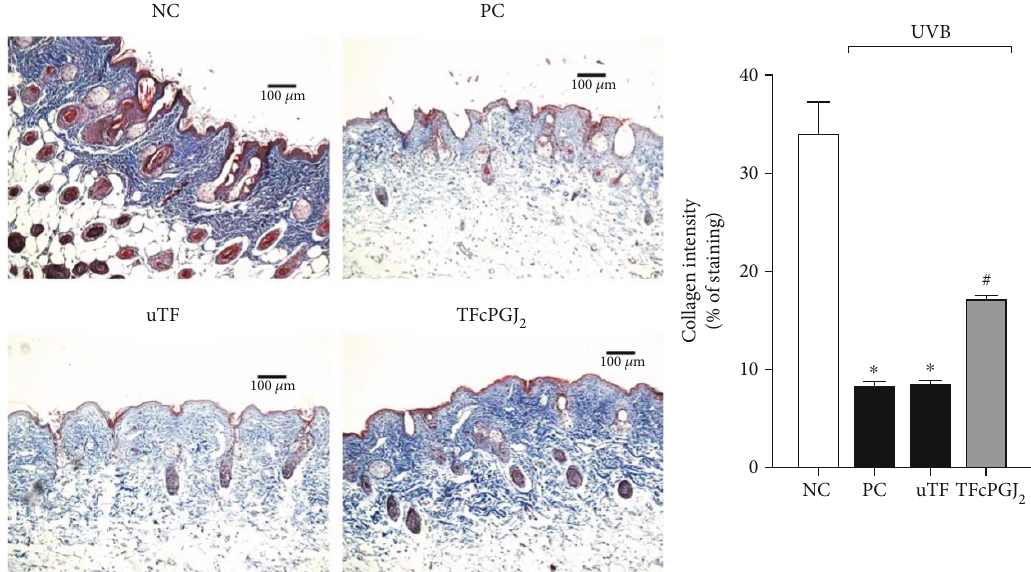
Figure 8: Topical formulation containing 15d-PGJ (TFcPGJ ) inhibits UVB irradiation-induced collagen fi ber damage. Collagen fi ber 2 2 degradation was evaluated with Masson ’ s trichrome staining in skin samples collected 12h after the irradiation. Collagen fi ber intensity and bundles shown in blue were examined by the ImageJ program (10x magni fi cation). NC: negative control; PC: positive control; uTF: unloaded topical formulation. Bars are means ± SEM of 6 mice per group and are representative of two separate experiments. One-way ANOVA followed by Tukey ’ s test. ∗ p < 0 : 05 versus the negative control group; # p < 0 : 05 versus UVB-stimulated